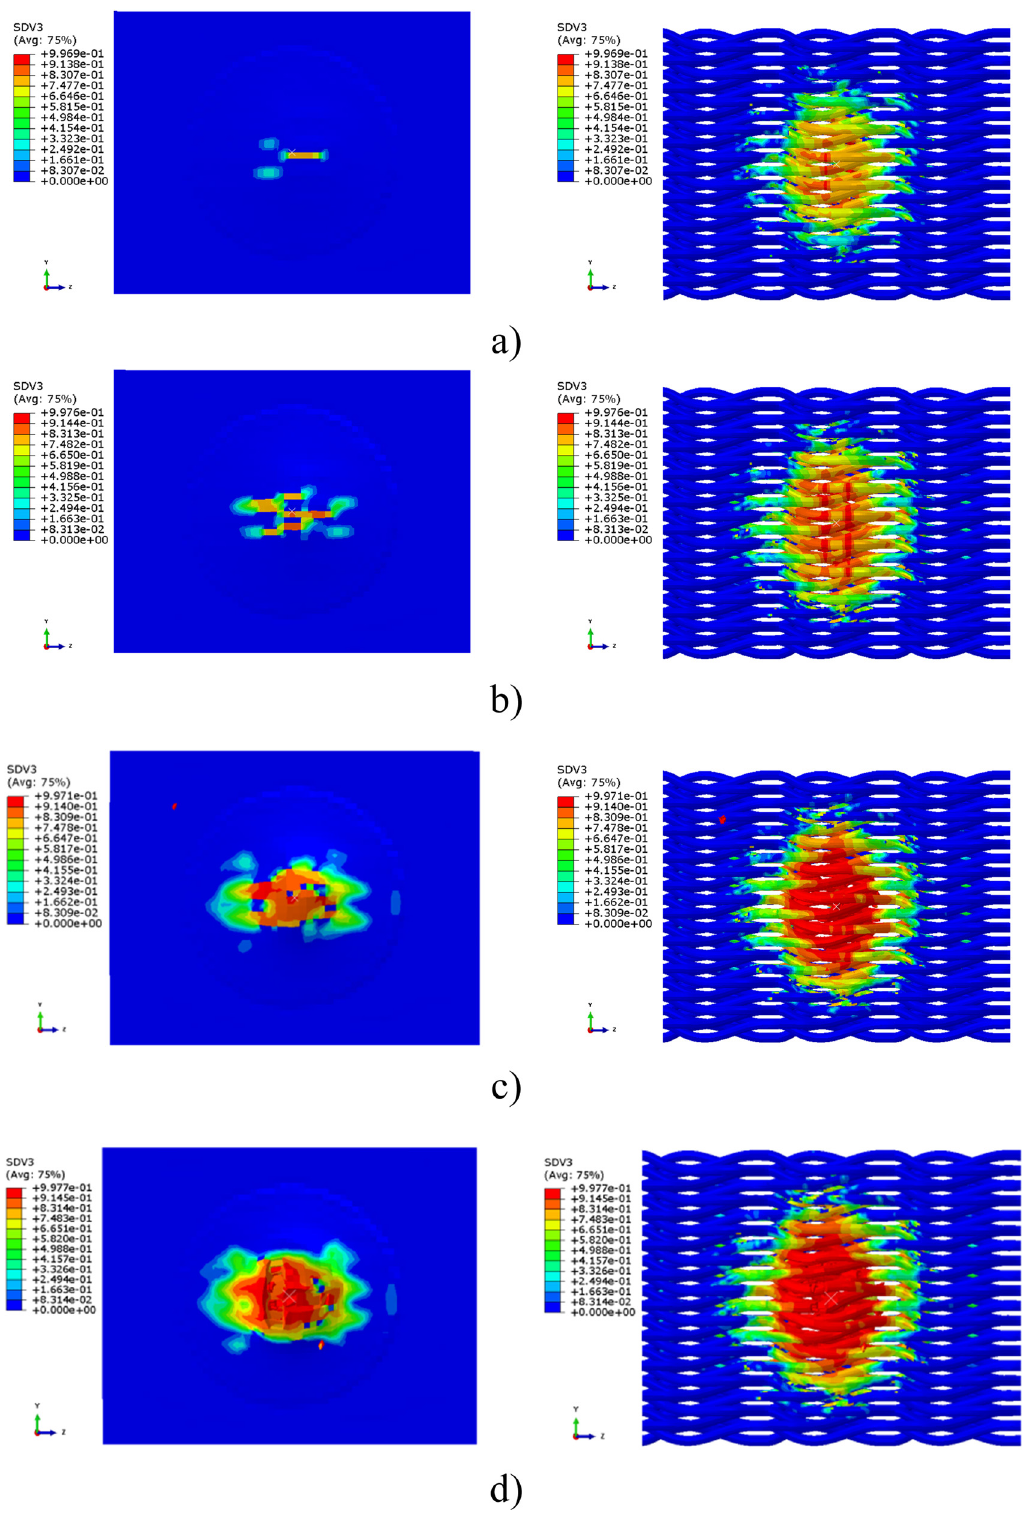
Figure 23: Expansion process of transverse tensile damage on the back of the specimen: ( a ) 1st impact, ( b ) 5th impact, ( c ) 10th impact, and ( d ) 20th